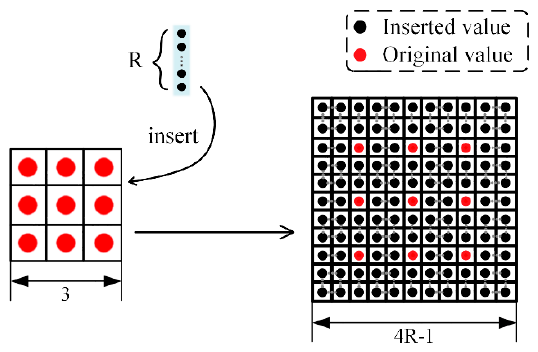
Figure 4. Detailed illustration of the dilated convolution.